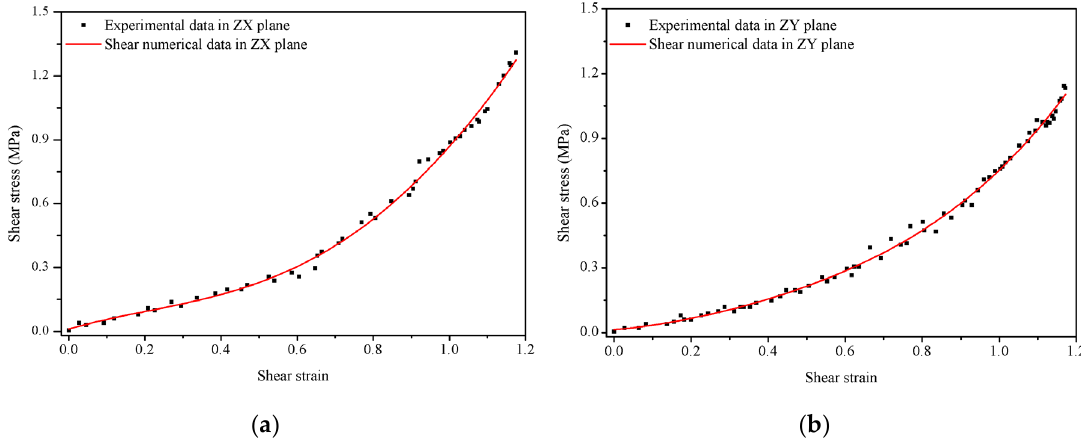
Figure 5. Shear properties of a GDL with experimental and numerical results in the ZX and ZY planes in ( a , b ).